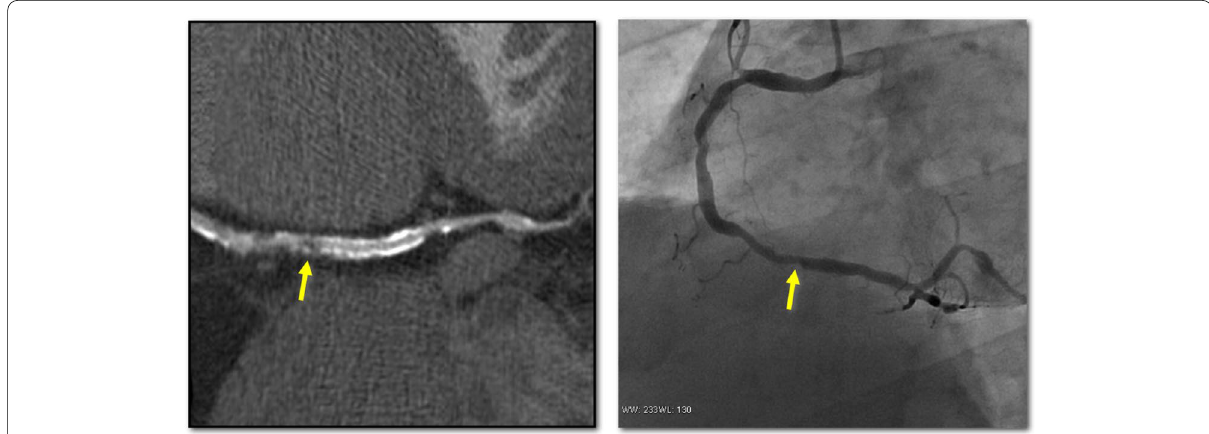
Fig. 3 In this CT image, blooming causes overestimation of the severity of ISR in the proximal part of this bare metal stent (yellow arrow). ICA reveals the stenosis to be